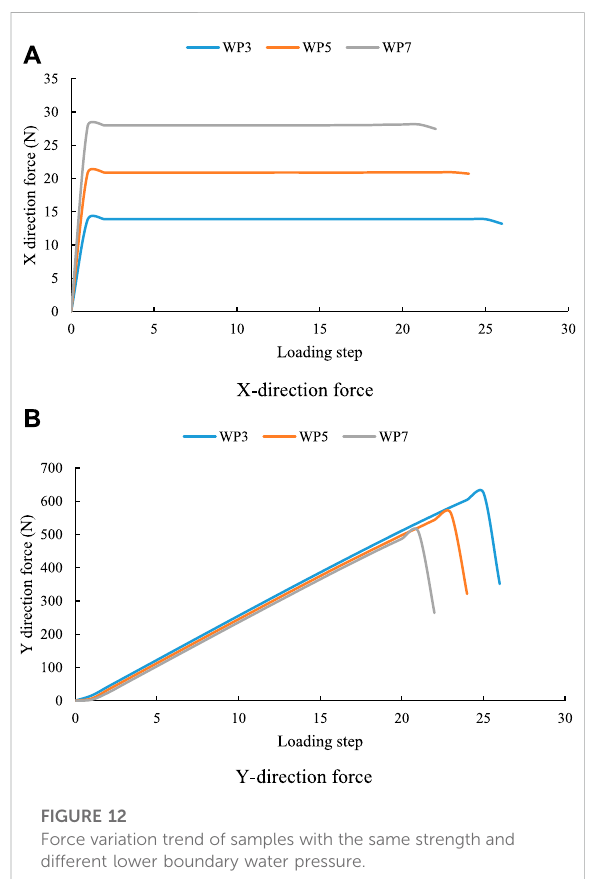
FIGURE 12 Force variation trend of samples with the same strength and different lower boundary water pressure.